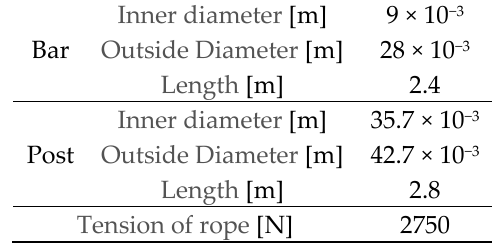
Table 2. Specification of the accelerometer.